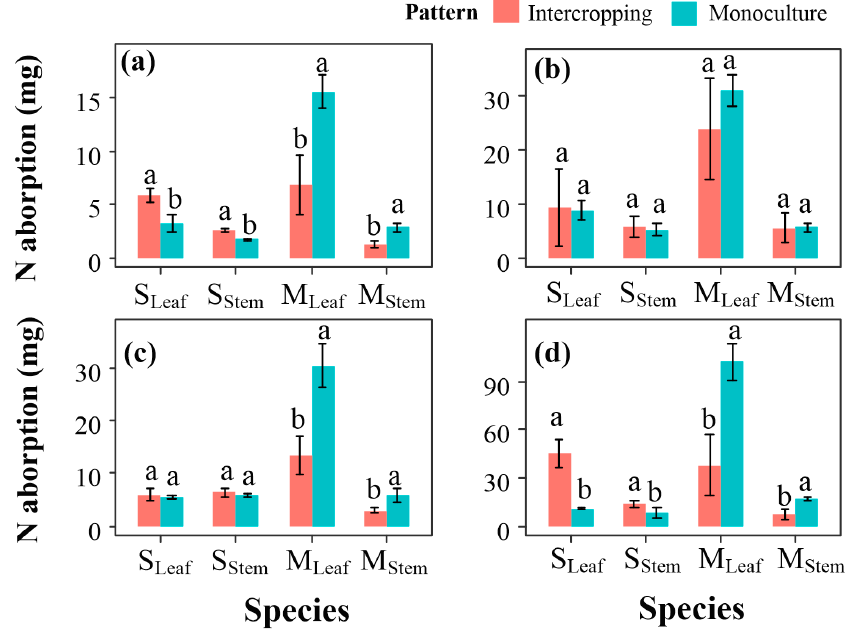
Figure 3. Effect of nitrogen treatment on N accumulation in leaves and stems of S. salsa and Z. mays L. in the cropping patterns. ( a – d ) N absorption under N0, N1, N2, and NH1 treatments, respectively. S Leaf and S team represent the N absorption of leaves and stems in suaeda, respectively, and M Leaf and M team represent the N absorption of leaves and stems in maize, respectively. Lower case letters indicate significant differences in N absorption between two cropping patterns.